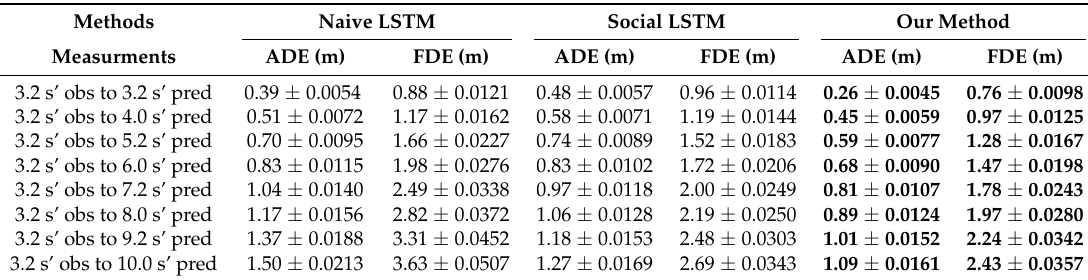
Table 3. Evaluation of prediction results.